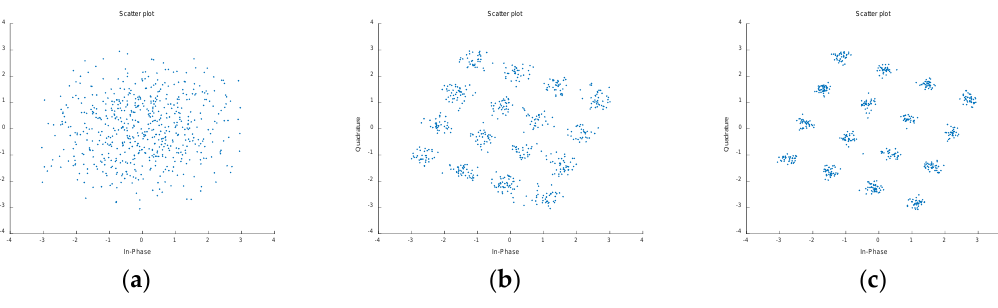
Figure 8. The constellations of the 16-QAM (quadrature amplitude modulation) signals: ( a ) distorted weak 16-QAM; ( b ) weak 16-QAM after mitigation by singular value decomposition (SVD)-based signal separation method; ( c ) weak 16-QAM after mitigation by the proposed signal separation method.